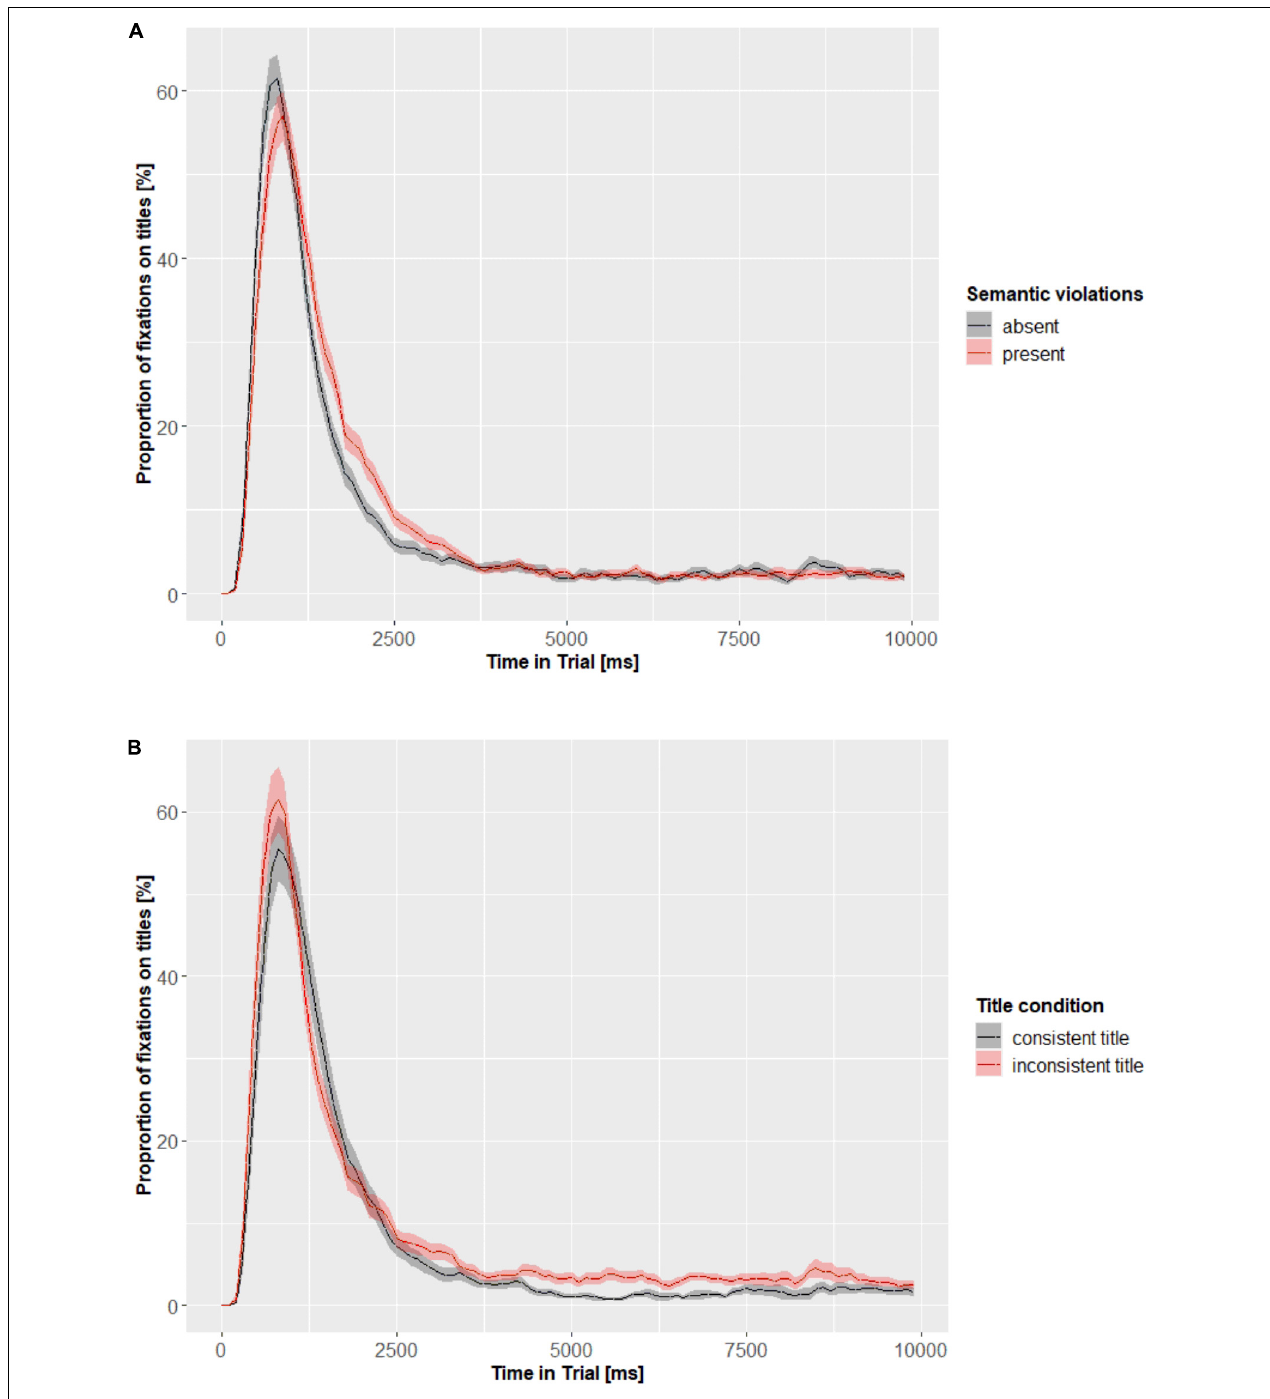
FIGURE 5 | Divergence curves for the effects of semantic violations (A) and title condition (B) on the percentage of fixations on titles. The divergence curves illustrate time-course of the data summarized into time-bins (100 ms) with respect to percentage of fixations on titles depending on the experimental condition. The shading represents 95% confidence